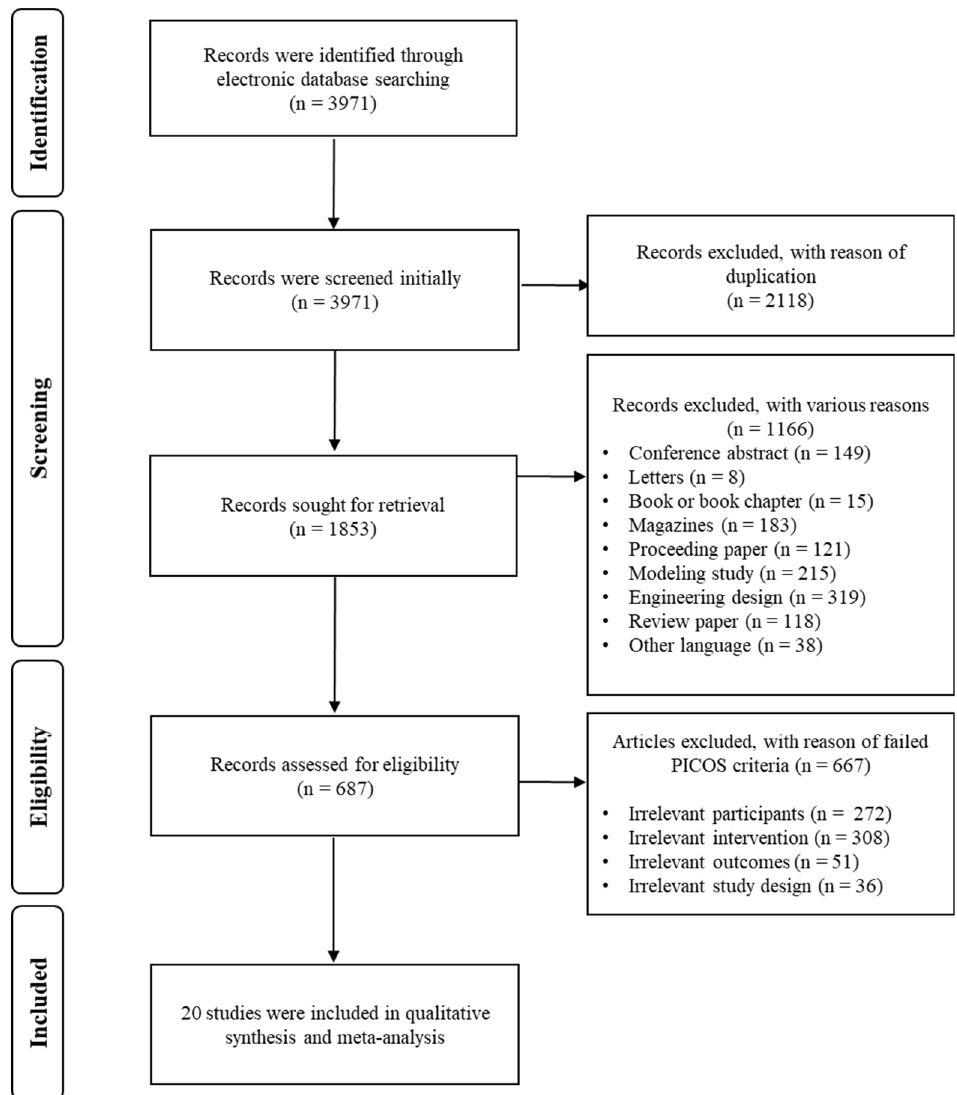
Figure 1. A Preferred Reporting for Items for a Systematic Review and Meta-analysis (PRISMA) flow diagram to explain the inclusion and exclusion process of the current study.